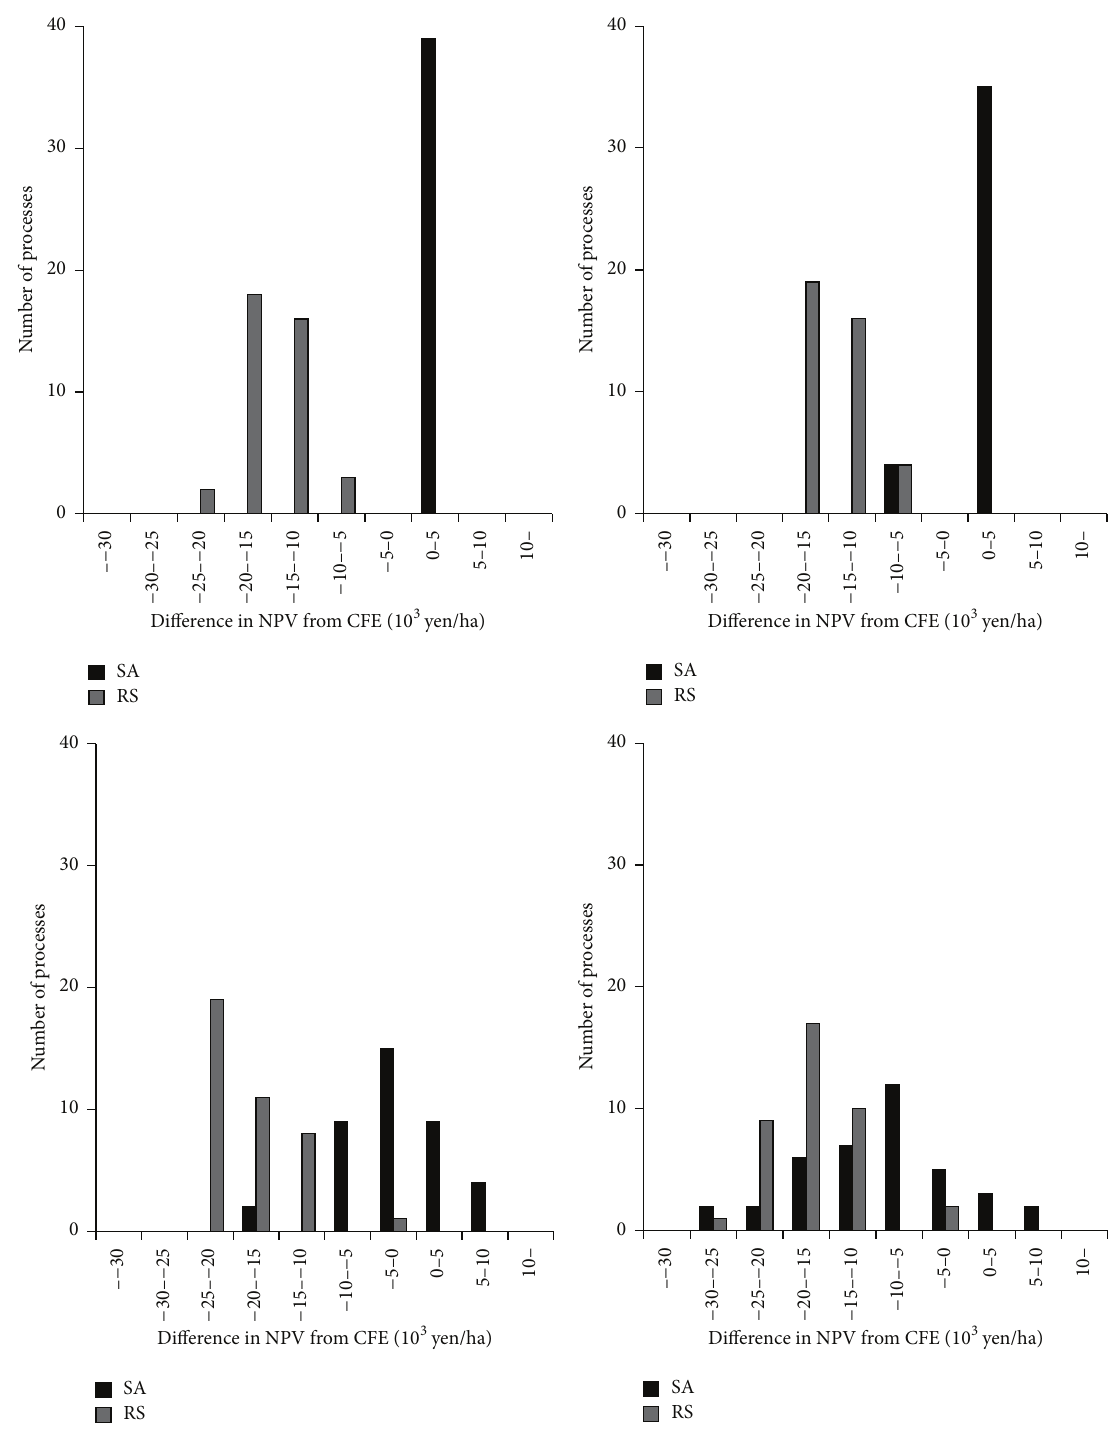
Figure 4: The difference between the optimal NPVs produced by SA (black bars) or RS (gray bars) and that derived using CFE (upper: S; lower: L; left: H; right: